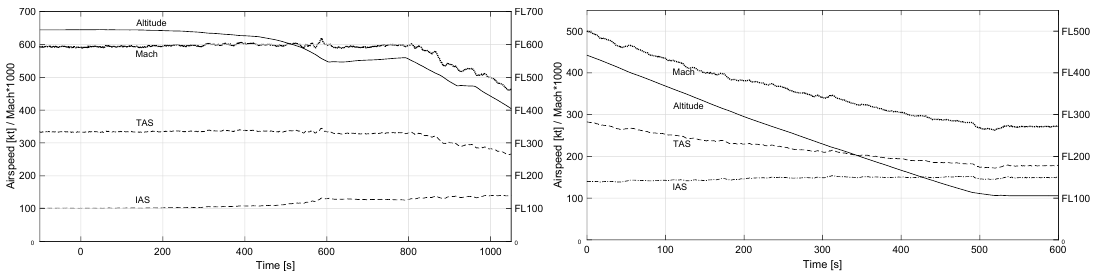
Figure 5. NS872 descent performance for Mission 872-0060.